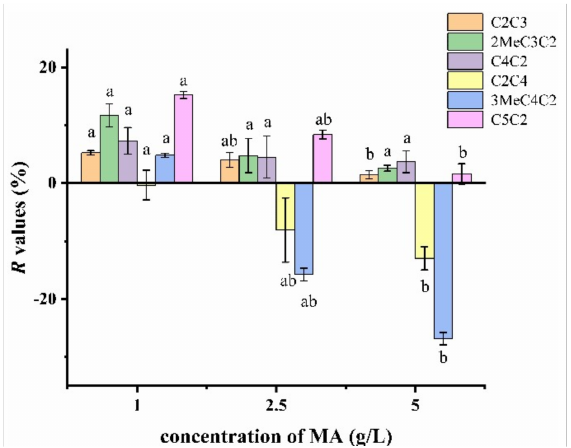
Figure 7. R values of esters in 1, 2.5 and 5 g/L of MA solution. Different letters indicate significant difference for each ester ( p < 0.05).